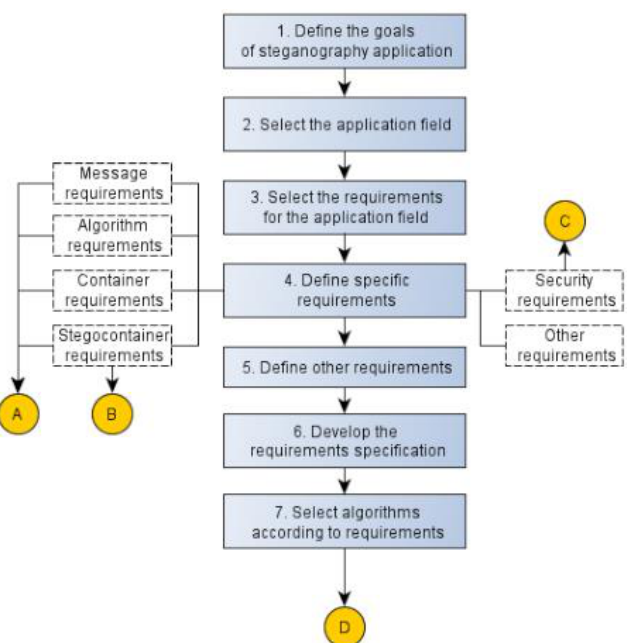
Fig. 5. The systematic approach to develop requirements specification for steganographic